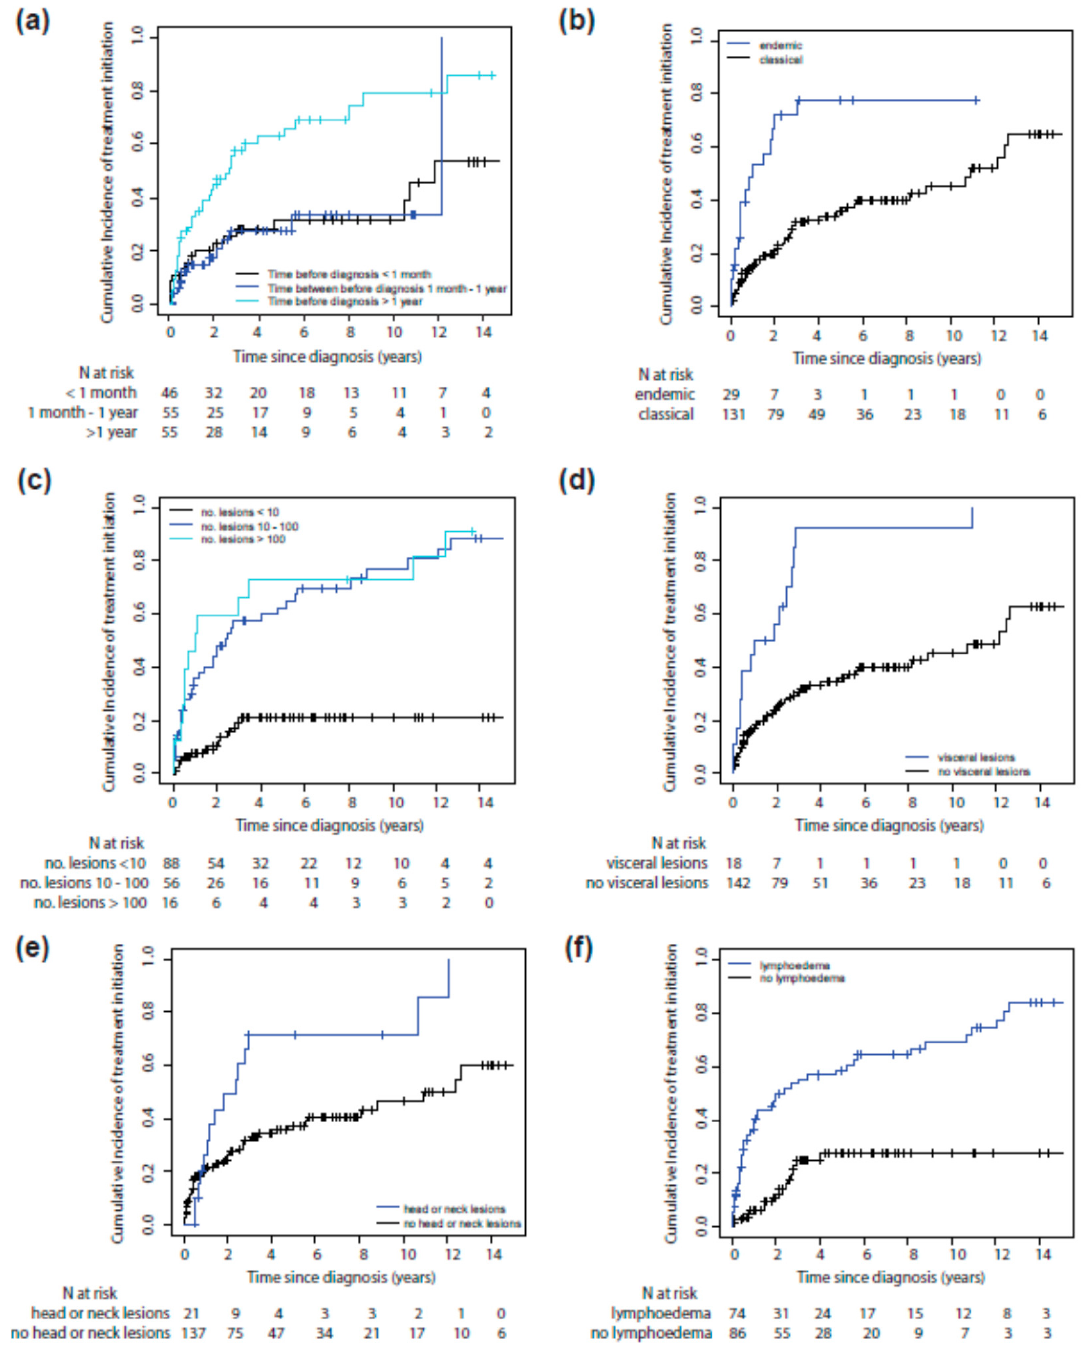
Figure 2. Cumulative Incidence of systemic treatment initiation in classic/endemic KS patients according to: time between first symptoms and diagnosis ( a ), KS subtype (endemic vs. classic) ( b ), total number of lesions ( c ), visceral localization ( d ), head/neck localization ( e ), or presence of lymphedema ( f ). Table 2. Univariate and Multivariate COX model identifying risk factors for systemic treatment initiation in patients with classic/endemic KS. HR: Hazard Ratio. CI: Confidence Interval.